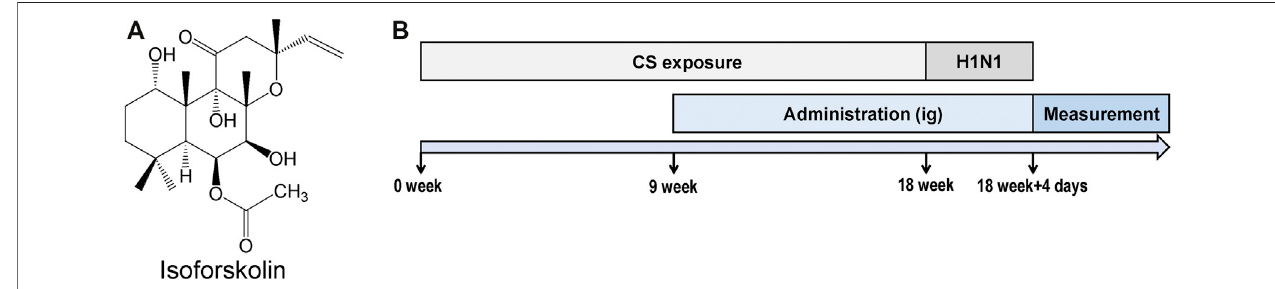
FIGURE1| Experimentaldesign. (A) Structureofisofoskolin. (B) Experimental fl owchart.Micewereexposedtocigarettesmokeonceadayfor18 weeksandthen intranasallychallengedwithH1N1virus,andmeasurementswereperformedonthe4thdayafterinfection.MicewereorallyadministratedwithISOF(0.5or2.0 mg/kg)or PDN (5 mg/kg) once daily after 8 weeks of exposure to cigarette smoke. OSE (60 mg/kg) was administered intragastrically before H1N1